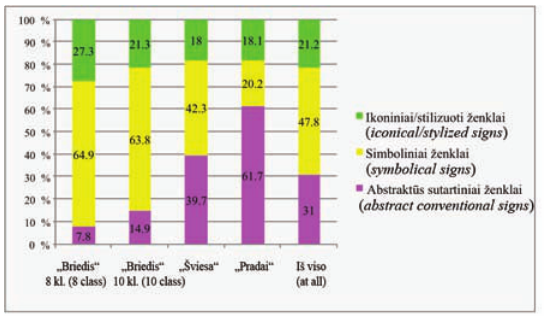
Fig. 2 . Sign association with shape in the analysed